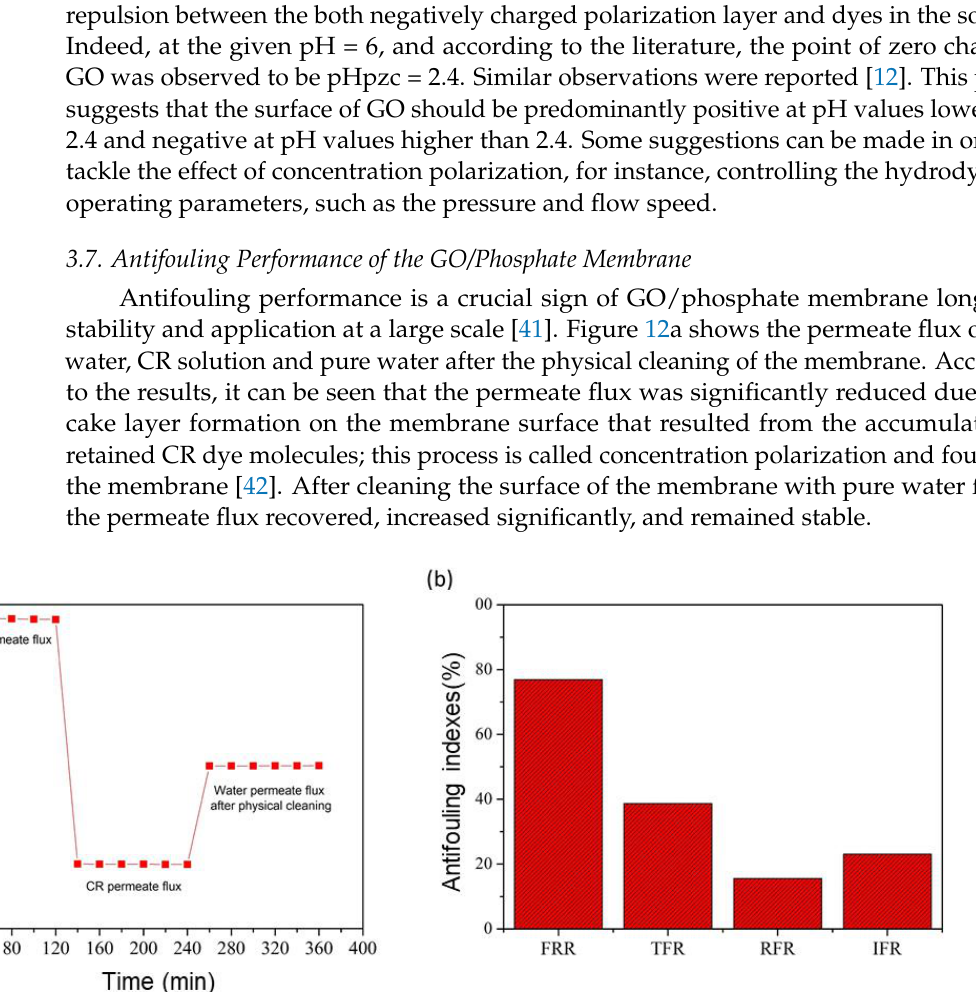
Figure 11. ( a ) Variation in water permeate flux of the GO/phosphate membrane as a function of the transmembrane pressure; ( b ) CR rejection rate as a function of the concentration.